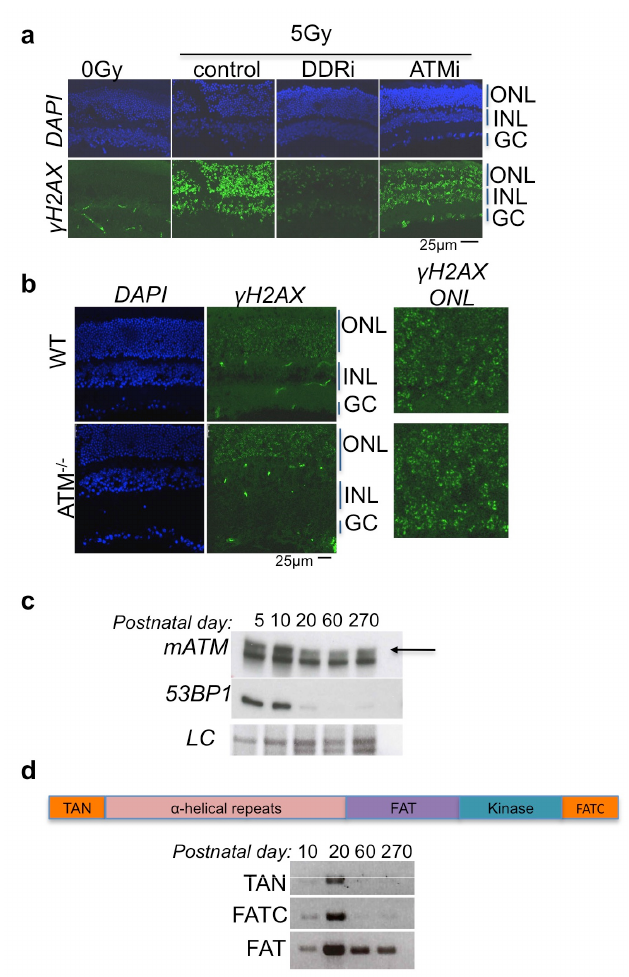
Figure 4. Loss of ATM function in retina. (a) Retinal explants pretreated with ATM inhibitor (ATMi) or PI3K inhibitor (DDRi) are irradiated and sections analyzed for γ H2AX. ( b ) ATM knockout adult mice retina analyzed for irradiation dependent γ H2AXaccumulation. ( c ) Western blot analysis of ATM and 53BP1 in micro-dissected neuronal retina. LC, Coomassie-equivalent staining of gels used as loading control (representation of n=2 independent repeats). ( d ) Cartoon depiction of domains of ATM protein. ( e ) Neural retina of mice was microdissected and cDNA was prepared. PCR performed using indicated domain-specific primers on ATM mRNA. Unlike FATC and TAN domain coding mRNA; the FAT-domain containing mRNA could be observed even in 5-month-old adult mice retina, indicating the presence of an alternatively spliced form of ATM in the